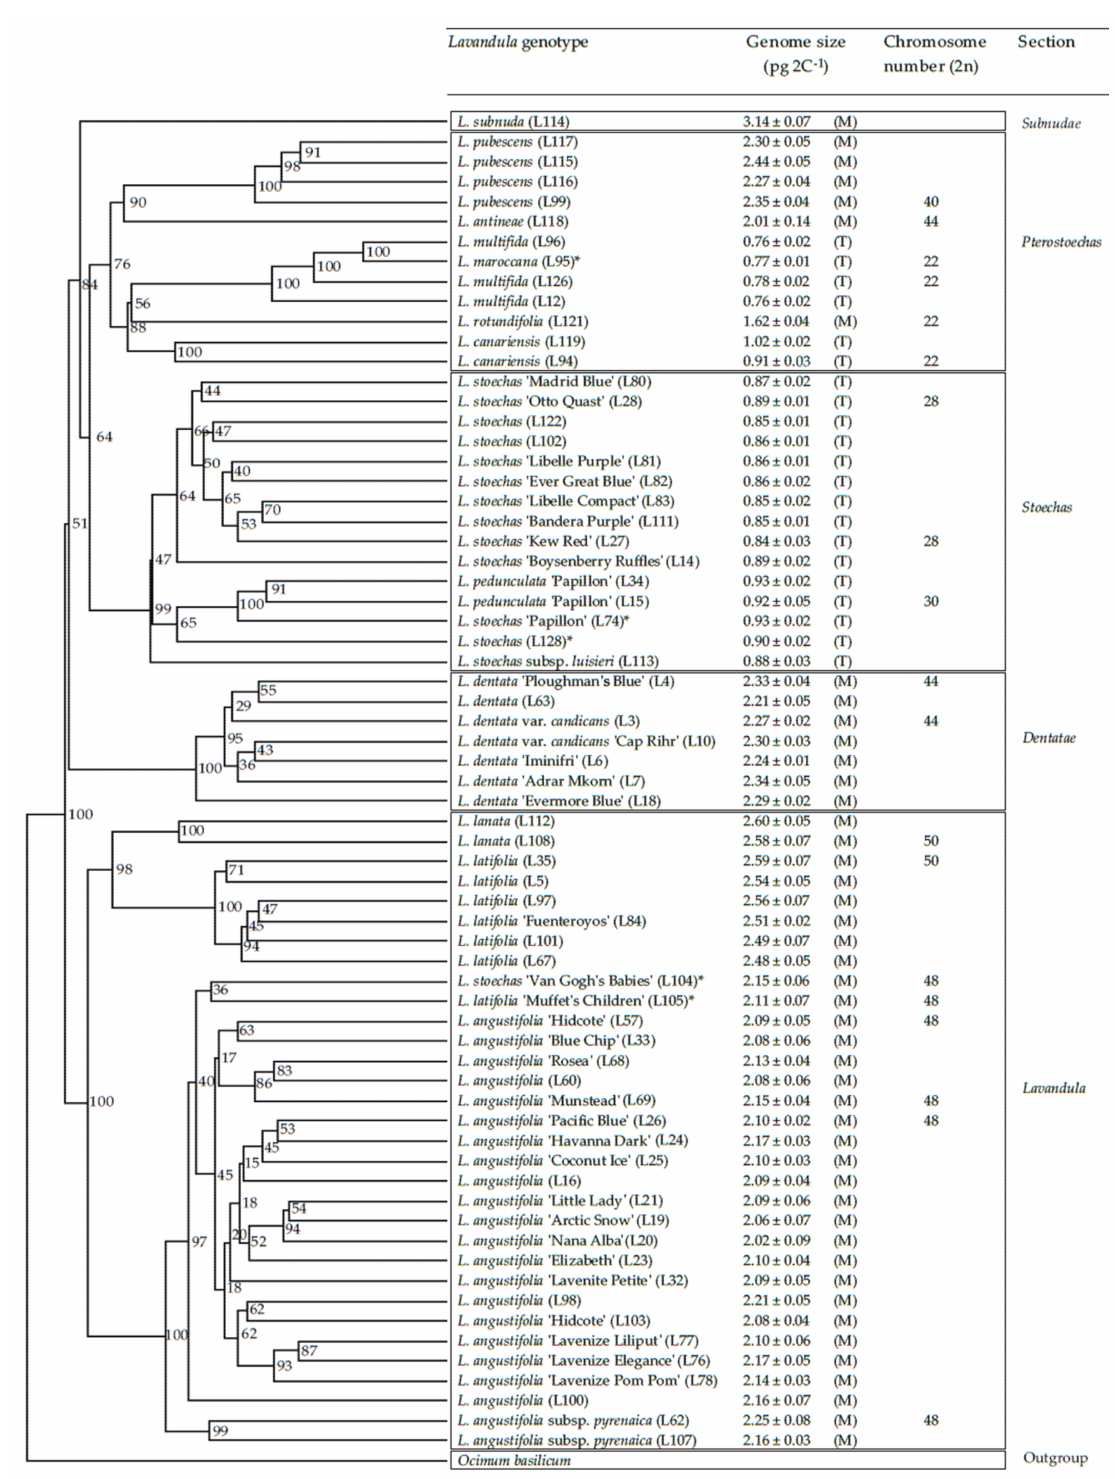
Figure 1. Phylogenetic tree of 67 Lavandula progenitor genotypes (species and commercial cultivars) clustered in 5 taxo- nomical groups. The dendrogram was created after conversion of AFLP data in a distance matrix and application of an average clustering method (UPGMA) in R Studio (R Studio version 3.6.3., 2020). Bootstrap values ( n = 1000) are to the right side of the branching node. Genome size and chromosome number measured in our study were added to the respective genotypes. The standard deviation on genome size measurements and plant species used as internal standard are men-tioned next to the 2C values ( Zea mays (M), Solanum lycopersicum (T)). Putative misnamed genotypes were marked with an asterisk (*) (Table